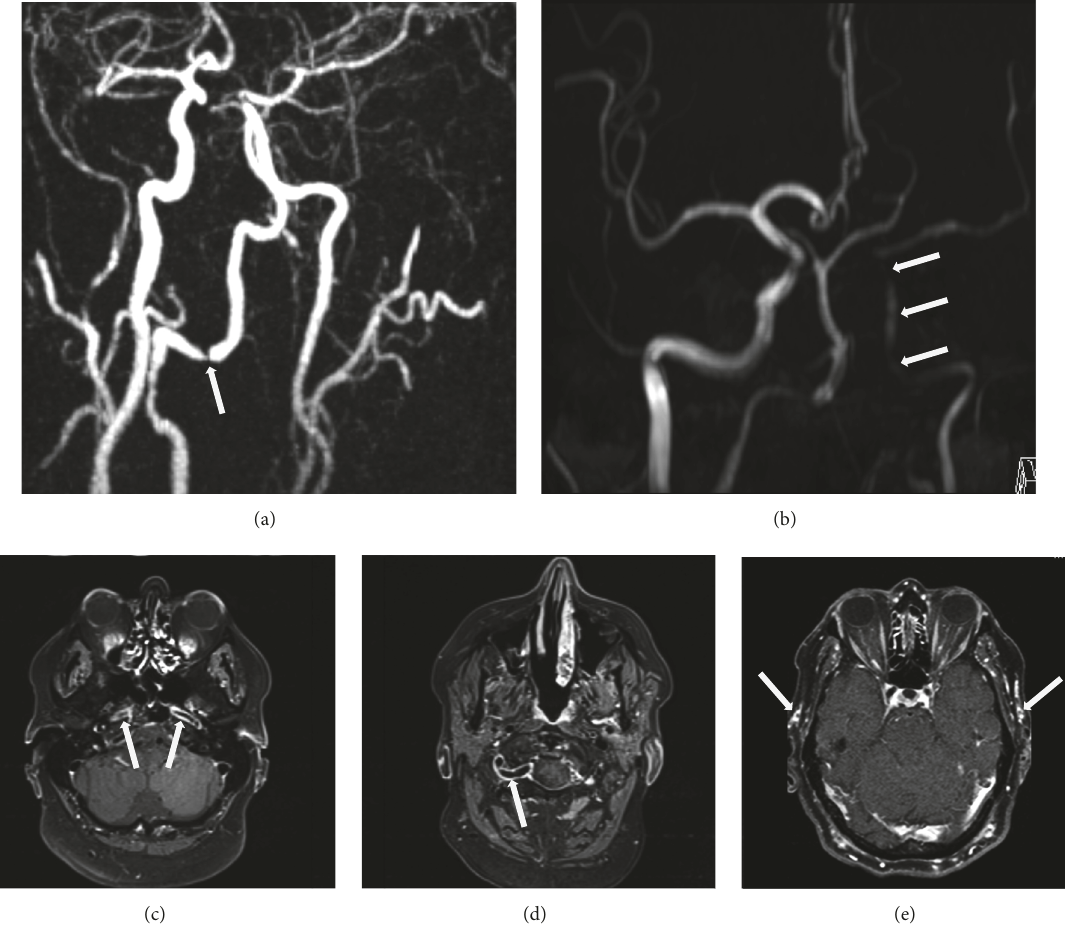
Figure 2: Magnetic resonance images of the affected arteries. High-grade stenosis of the right vertebral and the left distal internal carotid artery ((a), arrow) on a contrast enhanced magnetic resonance angiography. Long stenosis of the left ICA with tapering aspect ((b), arrows) on a follow-up time of flight MRI. Vessel wall enhancement of both internal carotid arteries ((c), arrows), and the right vertebral artery ((d), arrow), visible on a “dark blood” sequence. Contrast enhancement of both superficial temporal arteries ((e),